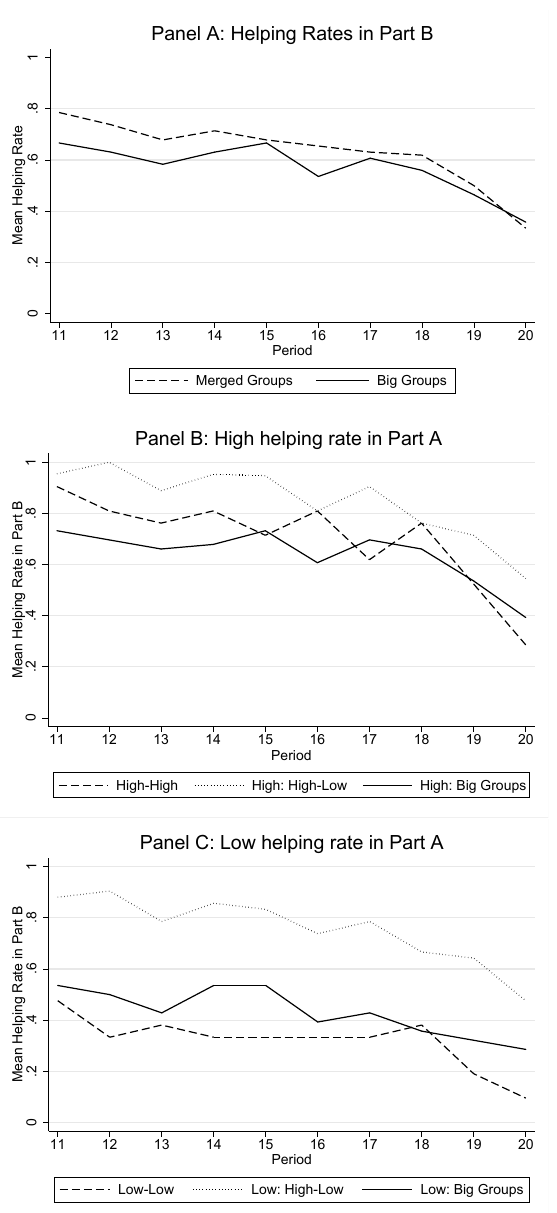
Figure A1. Helping rates in Part